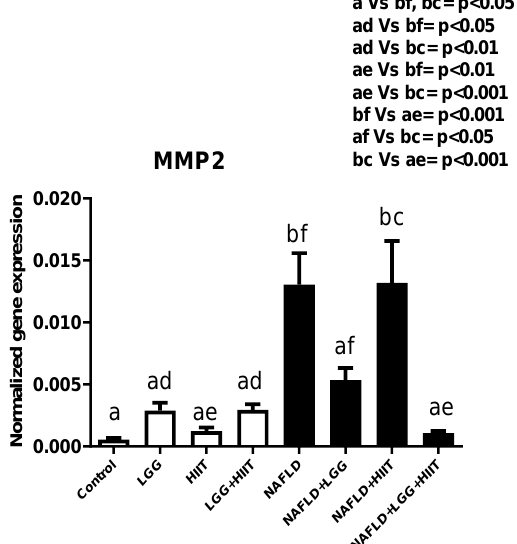
Figure 4: Liver tissue inhibitor matrix metallopro- teinase 2 ( MMP2 ) mRNA expression in different groups of study. All values are the mean ± SD (n = 10 per group). Values with different superscripts are significantly different, p < 0.05. LGG: Probiotic L. rhamnosus GG, HIIT: High intensity interval